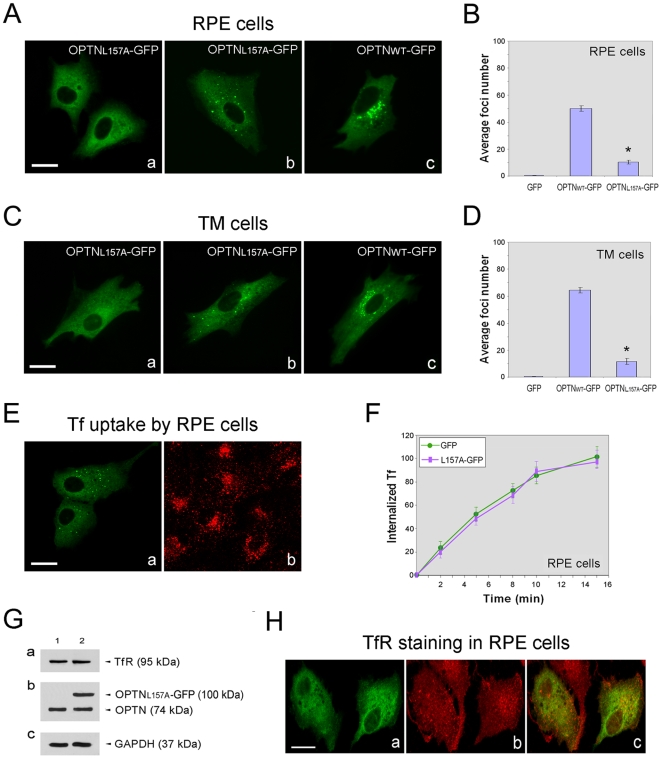
Cellular localization of OPTNL157A-GFP and effects of OPTNL157A-GFP expression on Tf uptake, total TfR level, and TfR distribution.(A) RPE cells were transfected with pEGFP-N1 (GFP mock control, not shown), pOPTNL157A-GFP (a and b) or pOPTNWT-GFP (c) for 16 h. Representative confocal images shown in Aa and Ab depict two major patterns of OPTNL157A distribution. Scale bar, 20 µm. (B) The number of foci in at least 60 RPE transfectants was counted and the average number of foci per transfectant is shown. Data (mean ± SD) presented are representative from three independent experiments. *, P<0.0001 compared to OPTNWT-GFP-expressing cells. (C) Human TM cells were transfected pEGFP-N1 (mock control, not shown), pOPTNL157A-GFP (a and b) or pOPTNWT-GFP (c). Two patterns of OPTNL157A distribution are seen in a and b. Scale bar, 20 µm. (D) The number of foci in TM transfectants was counted. The average number of foci per transfectant (mean ± SD) is presented. *, P<0.0001 compared to OPTNWT-GFP-expressing cells. (E) Fluorescent images of OPTNL157A-GFP-expressing RPE cells after internalization of TR-Tf for 15 min. The transfected cells are in green (Ea) and the internalized TR-Tf is shown in red (Eb). Scale bar, 20 µm. (F) Quantification of TR-Tf uptake in OPTNL157A-transfected RPE cells. Fluorescence intensity of TR-Tf, determined as in Fig. 1B, is expressed as percentage relative to that of the 15-min uptake in GFP-expressing controls. Data (mean ± SD) presented are representative of three independent experiments. (G) Lysates (50 µg total protein) from RPE cells transfected with pEGFP-N1 (lane 1) or pOPTNL157A-GFP (lane 2) were immunoblotted with anti-TfR (Ga), anti-optineurin (OPTN) (Gb), and anti-GAPDH (Gc, used to control protein loading) antibodies. Total level of the 95-kDa TfR was similar in lanes 1 and 2. A 74-kDa endogenous optineurin band and a 100-kDa OPTNL157A-GFP band were detected. (H) RPE cells transfected with pOPTNL157A-GFP (Ha, green) were immunostained with anti-TfR (Hb, red). The diffuse distribution of OPTNL157A-GFP overlapped with that of TfR in yellow in the merged image (Hc).